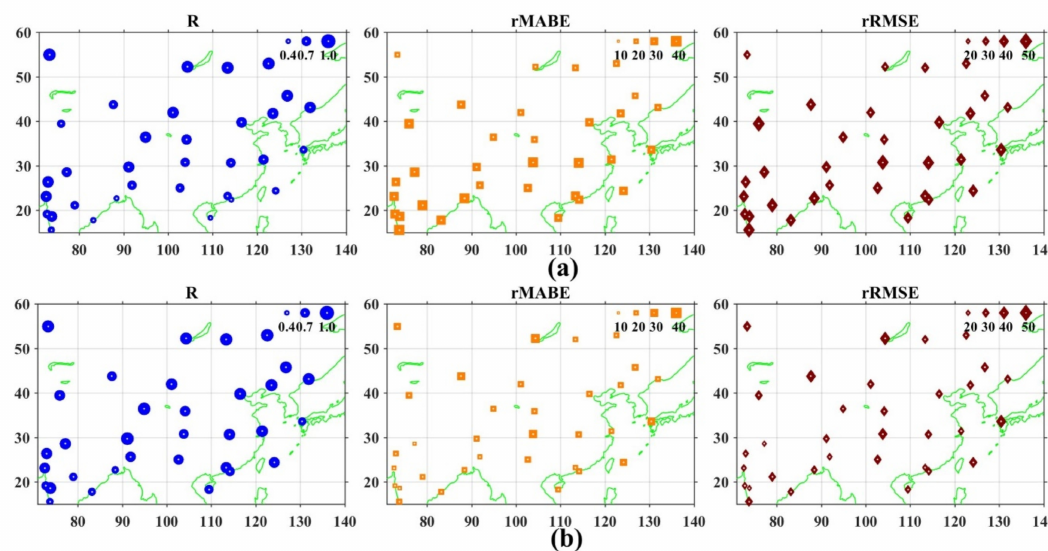
Figure 5. Spatial mapping of R, rMABE and rRMSE: ( a ) results for ERA5; ( b ) results for estimates of JiEA. Values are calculated from valid records of each station at daily